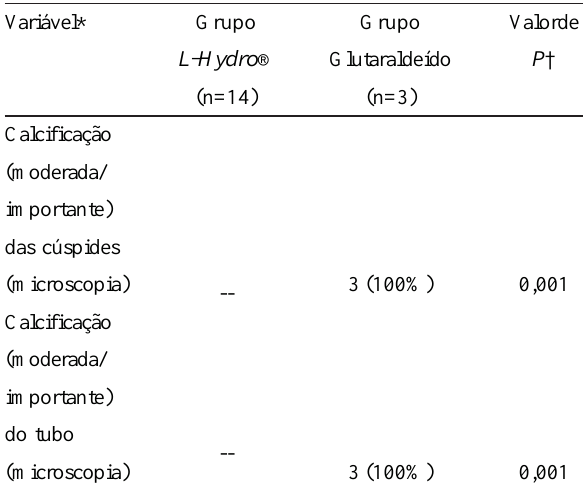
Tabela 6. Análise estatística microscopia (Grupos L-Hydro® e